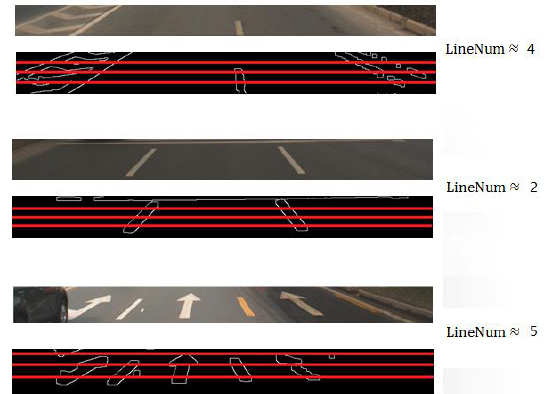
Figure 8. AOI map, crossing line map of a non-crossing area, as well as strip number calculated